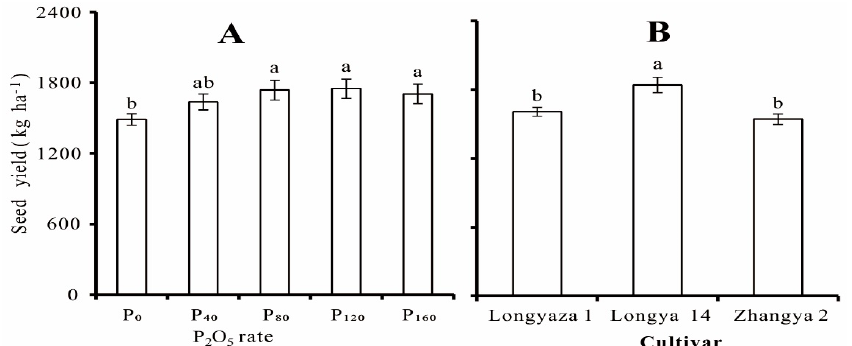
Figure 2. Effects of the P fertilization level (A) and cultivar (B) on the seed yields of flax across 2018 and 2019 in Yongdeng, China. Data are expressed as means ± standard errors (SE) ( n = 15). Different letters indicate means that are significantly different at p < 0.05 according to the Tukey test.